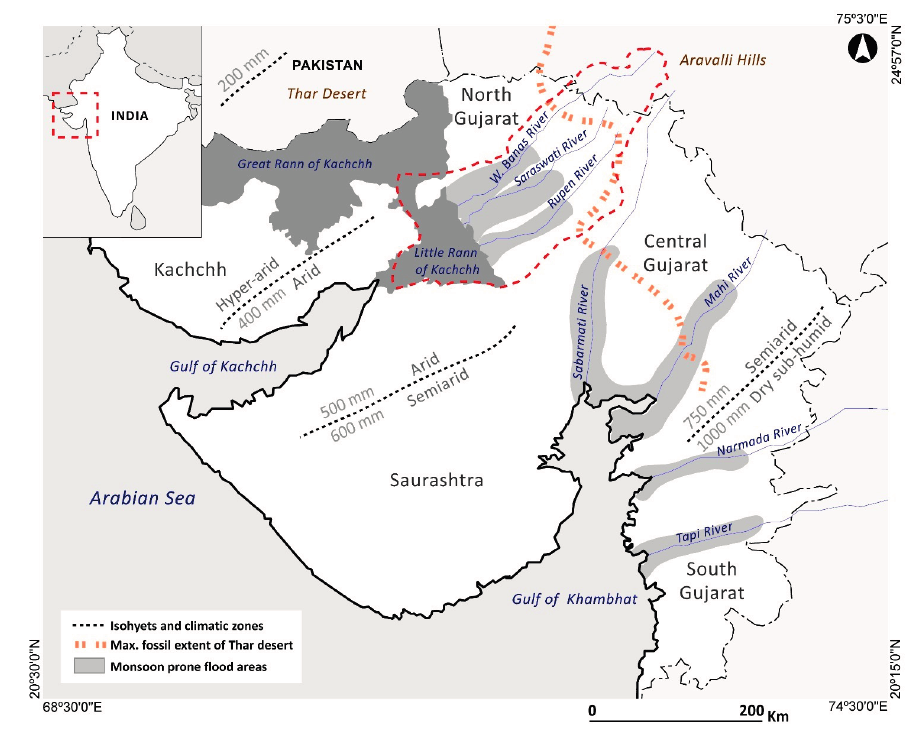
Figure 1. Location map of the NoGAP study area (thick dotted red line). Alluvial flood-prone areas are indicated as medium grey shading (after Attri and Tyagi [28], p. 104). Isohyet lines and climatic zones are from Juyal et al. [25] (p. 2633), and the maximum fossil extent of Thar Desert is after Singhvi et al. [29] (p.